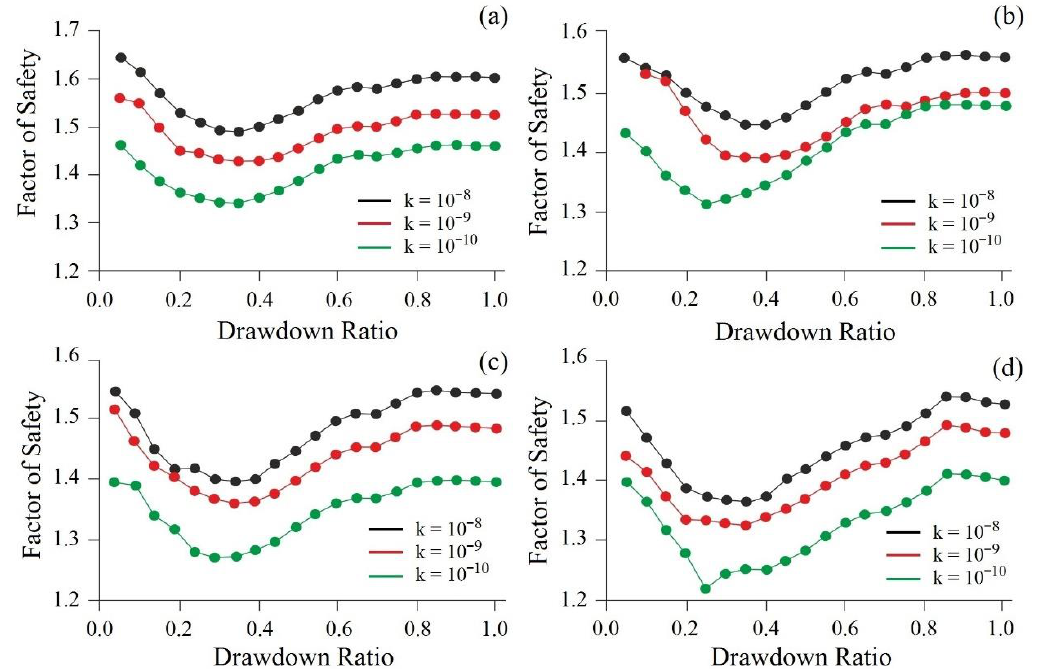
Figure 7. The trend of safety factors versus drawdown ratio by FEM: ( a ) R = 0.1 m/day, ( b ) R = 0.2 m/day, ( c ) R = 0.4 m/day, ( d ) R = 1 m/day.